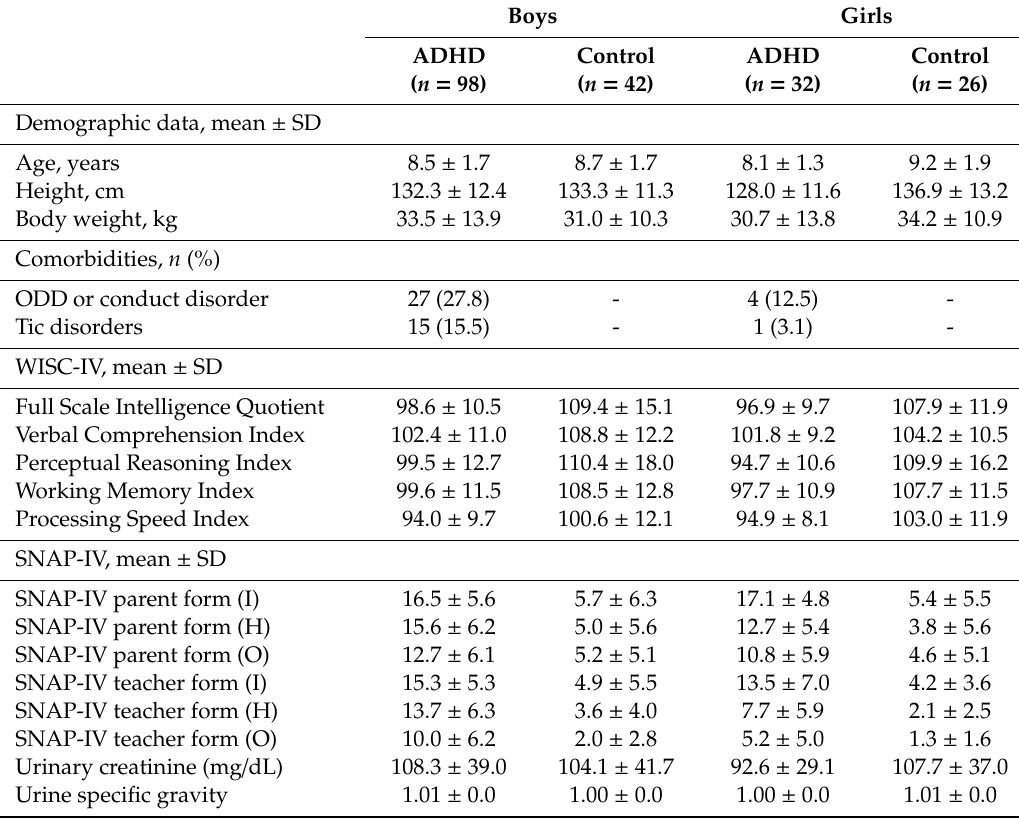
Table 1. Comparisons of demographic data and psychopathology evaluations in boys and girls among patients with attention-deficit / hyperactivity disorder (ADHD) and healthy